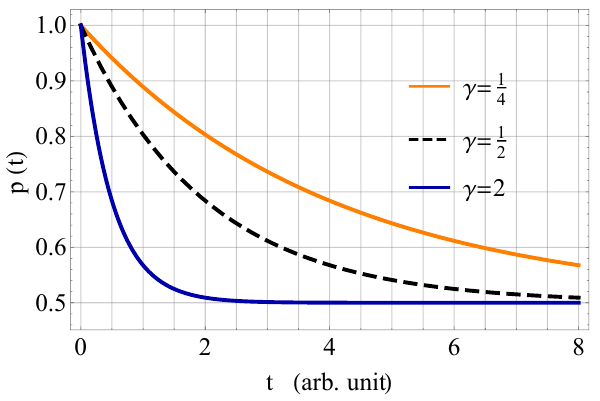
Figure 3. Plots of p ( t ) according to (23) for three values of γ